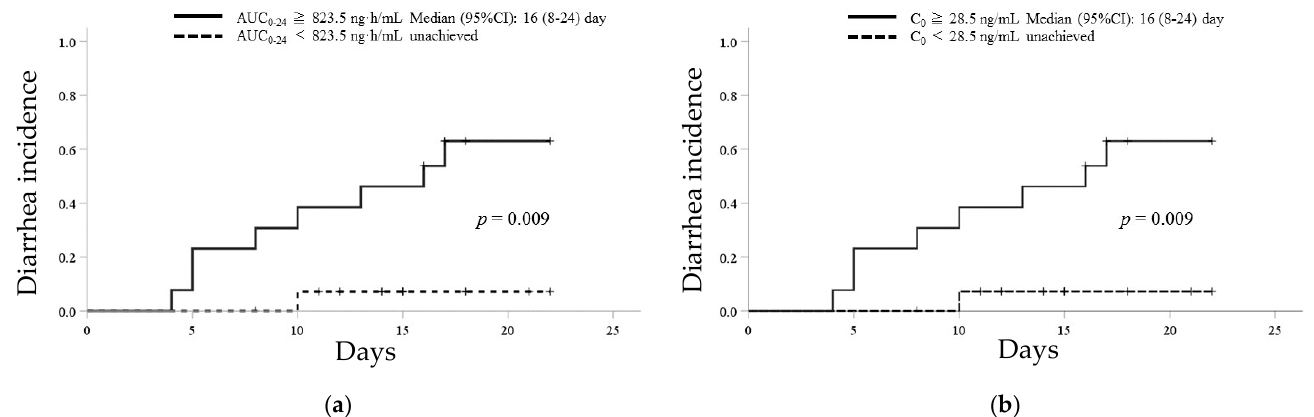
Figure 3. Kaplan–Meier analysis for time to the incidence of grade 2 diarrhea based on the cut-off values of AUC 0–24 (823.5 ng·h/mL) and C 0 (28.5 ng/mL) of afatinib. Kaplan–Meier curves for the incidence of grade 2 diarrhea in patients with ( a ) AUC 0–24 of greater than or equal to 823.5 ng·h/mL (solid line) and less than 823.5 ng·h/mL (dotted line) and with ( b ) C 0 of greater than or equal to 28.5 ng/mL (solid line) and less than 28.5 ng/mL (dotted line).